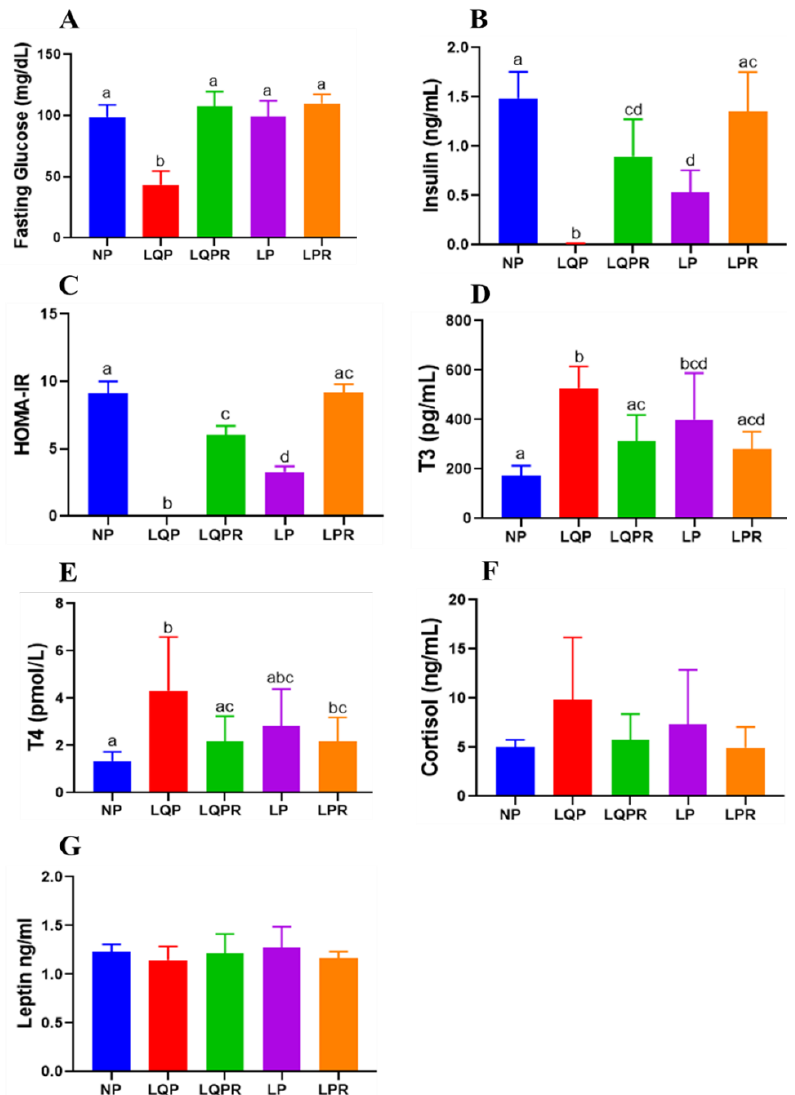
Figure 5. Effect of maternal protein restriction followed by rehabilitation on the glucose homeostasis and hormone profile in the offspring: fasting glucose, insulin, T3, T4, and cortisol were estimated in the offspring’s plasma at the end of the experiment. ( A ) Fasting glucose levels, ( n = 8 per group), ( B ) insulin levels, ( n = 6 per group), ( C ) HOMA-IR ( n = 6 per group), ( D ) T3 levels ( n = 6 per group), ( E ) T4 levels ( n = 6 per group), ( F ) cortisol levels ( n = 6 per group), and ( G ) leptin levels ( n = 8 per group). The bars indicate the mean ± SD, and the bars that share different superscript letters differ significantly ( p < 0.05). NP, normal protein; LQP, low-quality protein; LQPR; low-quality protein group rehabilitated with the NP diet; LP, low protein; LPR, low-protein group rehabilitated with the NP